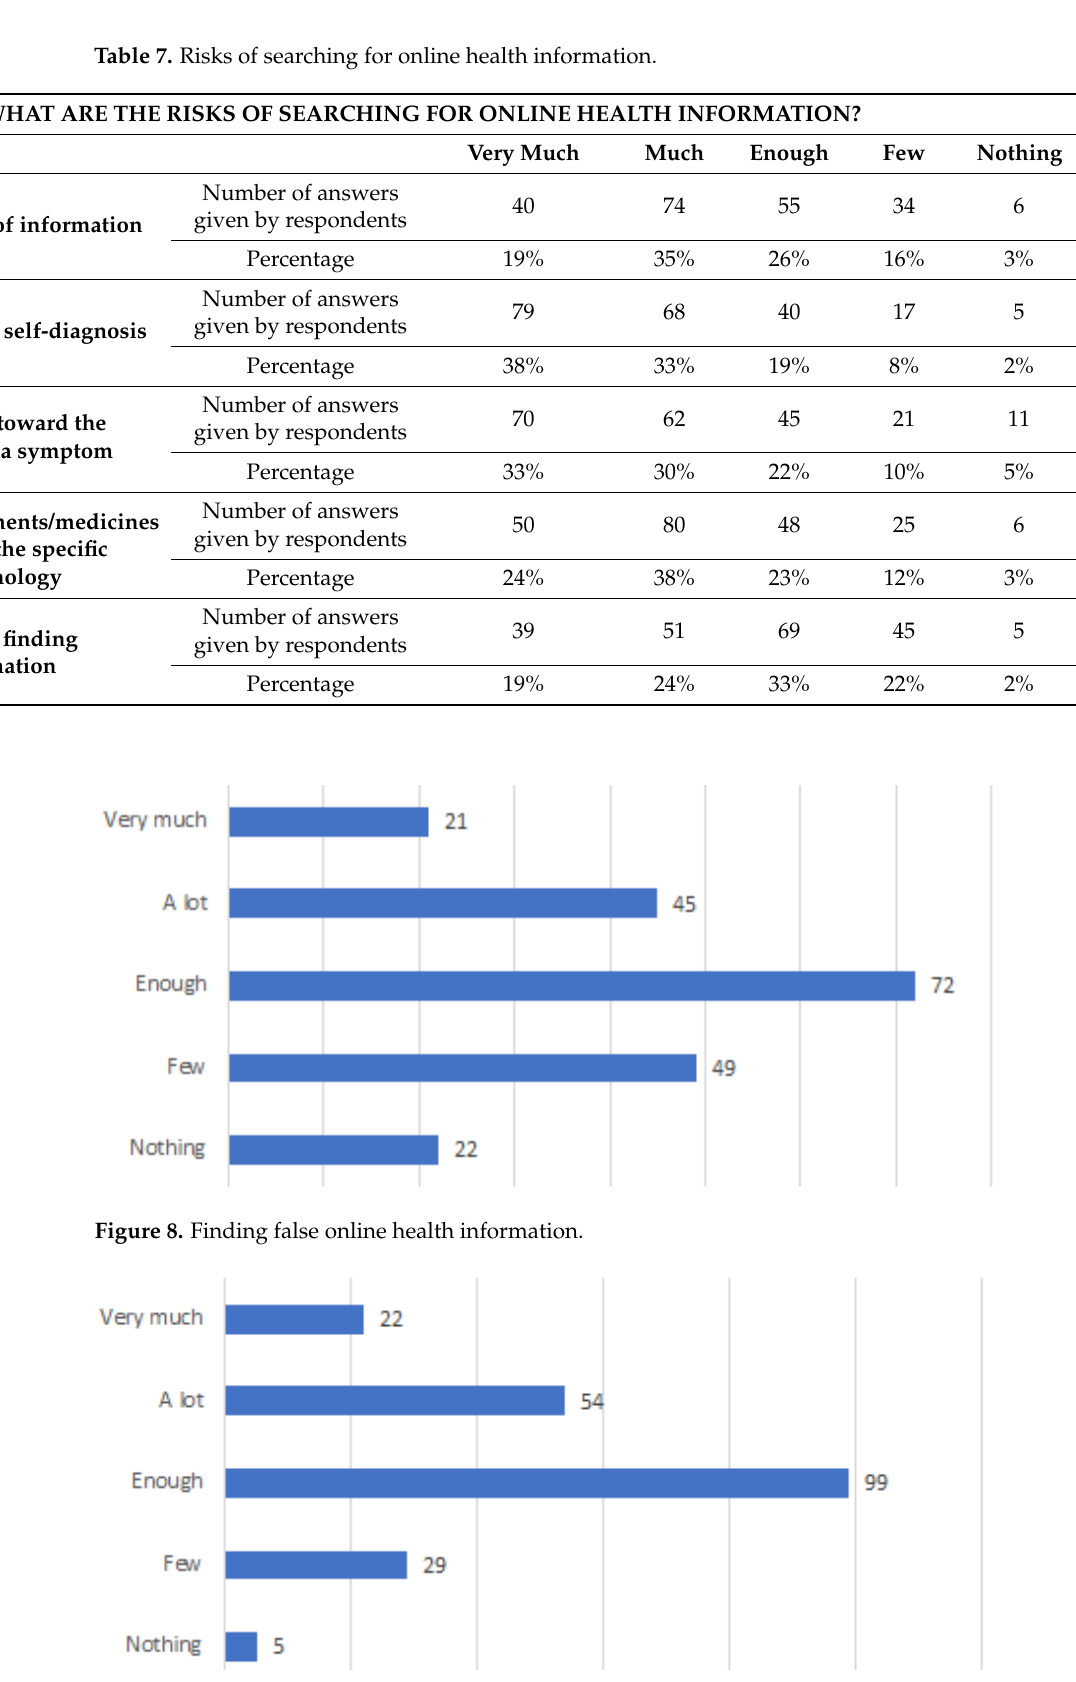
Figure 9. Ability to distinguish true and false online health information .